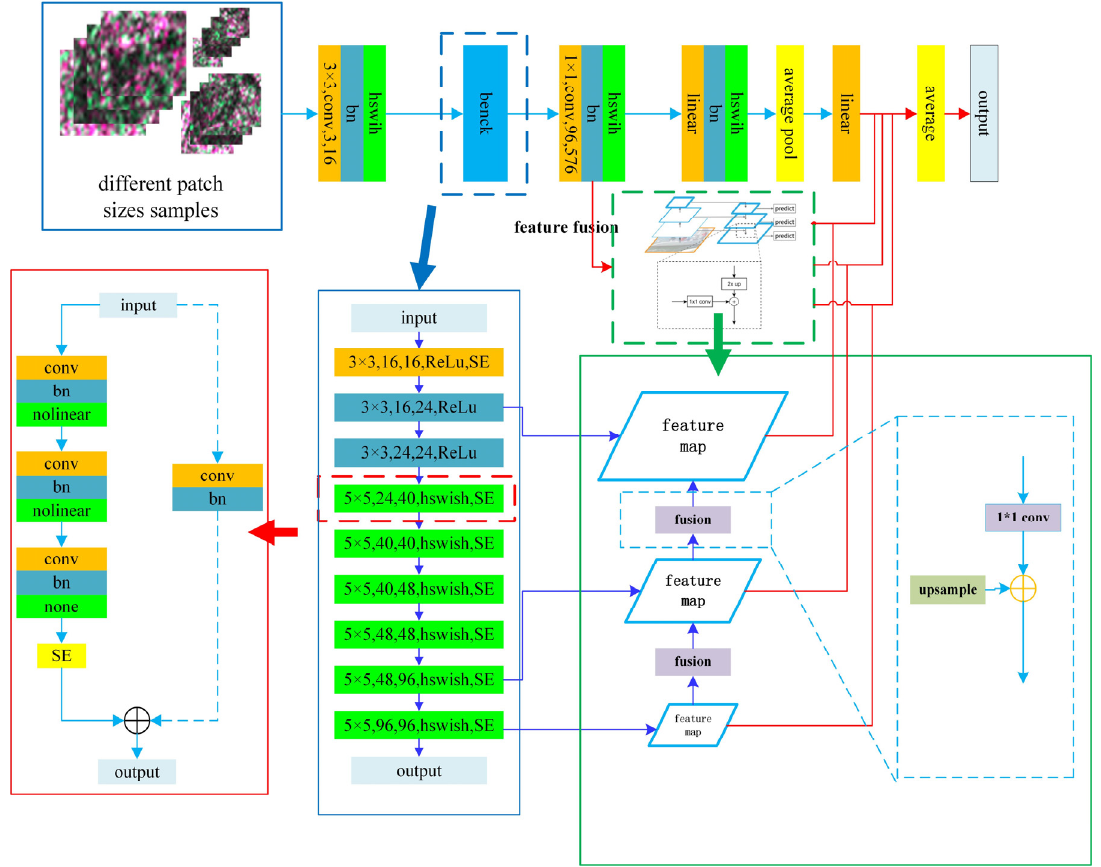
Figure 5. The entire structure of MSMN for sea ice classification using Gaofen-3.